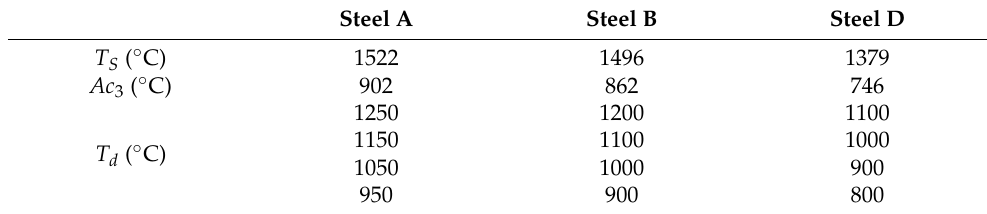
Table 2. Determined temperatures Ac 3 , T S and deformation temperatures T d